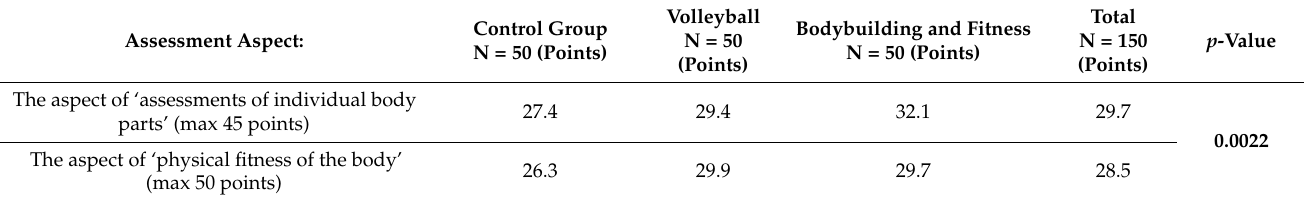
Table 3. Average evaluation of one’s own body based on the BES Body Evaluation Scale in aspects of items modifiable by diet and exercise and determining physical condition.